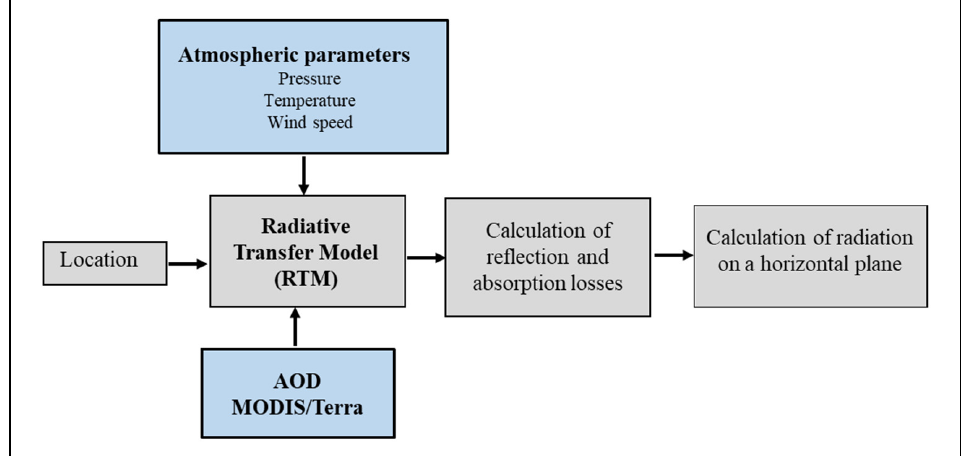
Figure 3. Schematic diagram of the model structure.